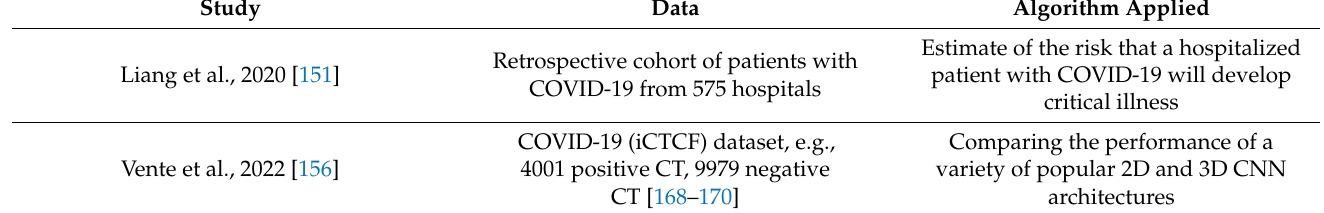
Table 3. Algorithms used in the process of dynamic development of AI